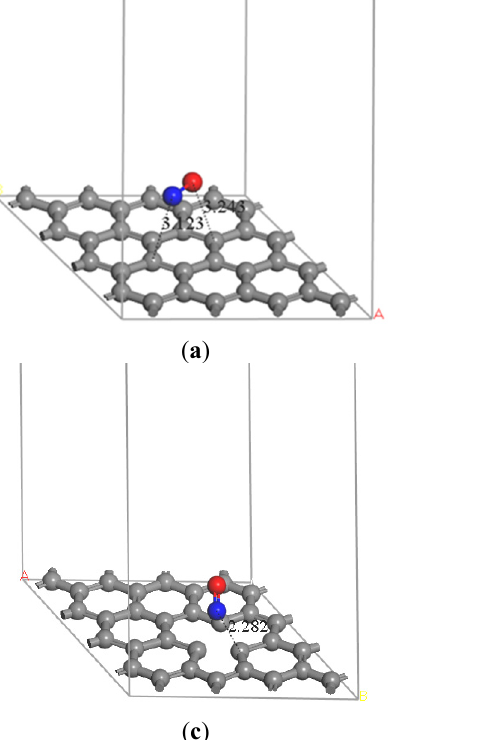
Figure 2. Optimized structure of ( a ) graphene-NO, ( b ) graphene-Na-NO, ( c ) gsv-NO, and ( d ) gsv-Na-NO. (The gray solid spheres indicate that the graphene surface and the purple, red, and blue spheres represent sodium, oxygen and nitrogen atoms, respectively.)